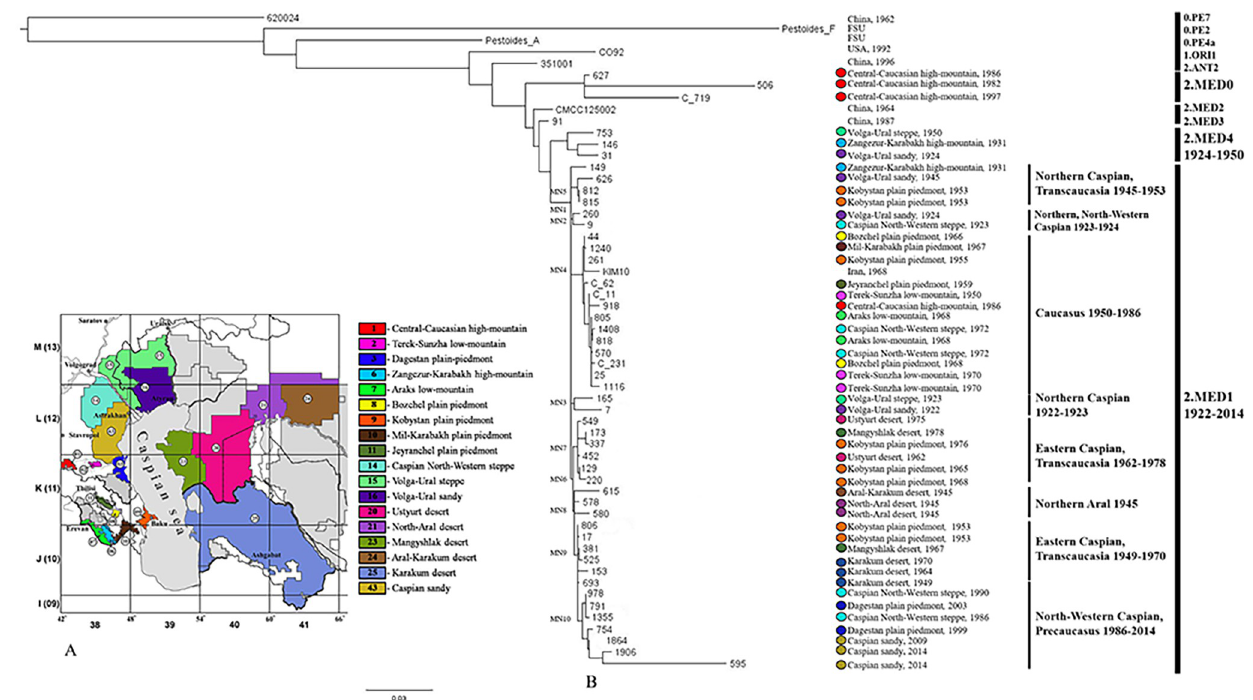
Fig 1. Maximum Likelihood dendrogram of phylogenetic relations of Yersinia pestis strains of the medieval biovar of the 2.MED1 phylogenetic branch from the plague foci of the Caucasus, the Northern Caspian and the Northern Aral Sea regions, and other foci of the world. A. Map of natural plague foci of the Caucasus, the Northern Caspian and the Northern Aral Sea regions in the Russian Federation and neighboring countries. The numbers correspond to the classification of plague foci adopted in Russia and other countries of the Commonwealth of Independent States. B. Maximum Likelihood tree based on 1324 core SNPs identified among 25 Y . pestis strains of the medieval biovar from the Caucasus, as well as among 24 strains of the medieval biovar from the Northern Caspian and Northern Aral Sea regions and 8 strains of different phylogenetic lineages from other regions of the world. SNPs in MN1-MN10 phylogenetic nodes are listed in the S4